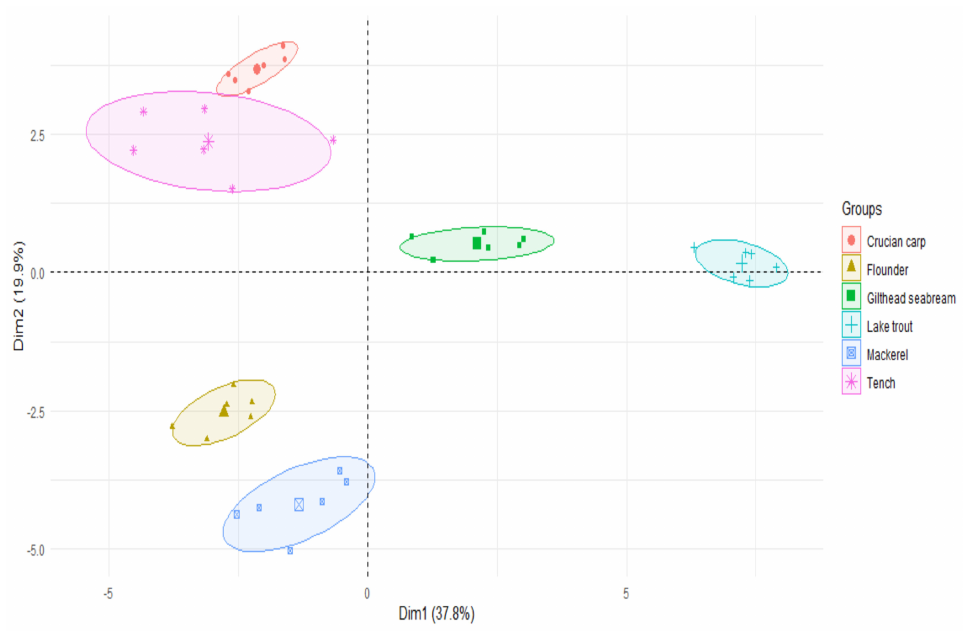
Figure 4. PCA plot, 2D, showing clusterings of fatty acid concentration in six examined fish